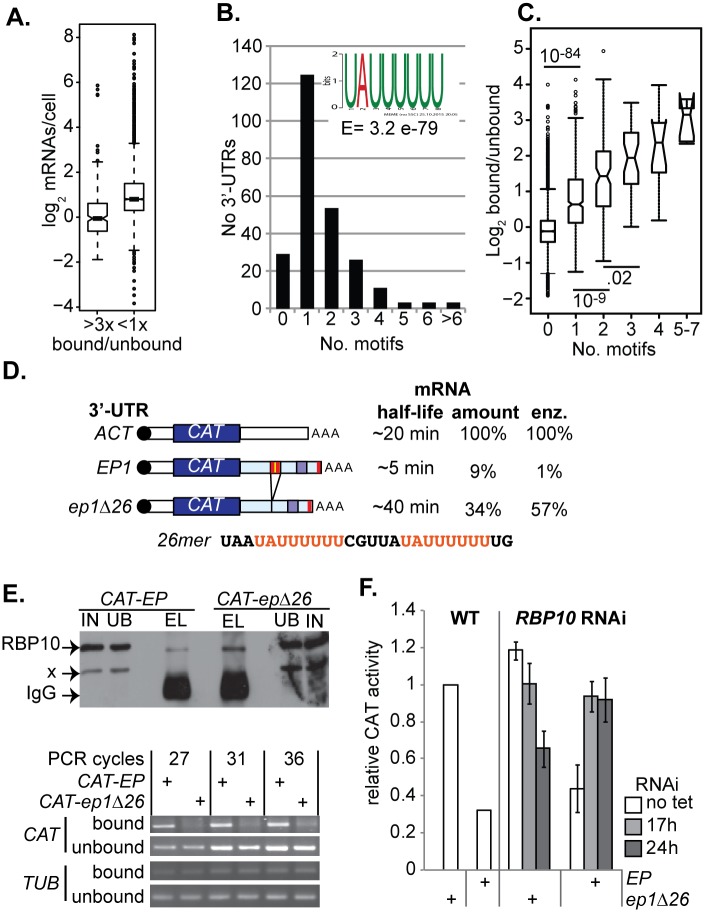
RBP10 targets a UAUUUUUU motif.A) Abundances of mRNAs that were at least 3x enriched in both RBP10-bound fraction, relative to those that were less than 1x enriched. B) The 3'-UTRs of 188 mRNAs that were at least 3x enriched in both RBP10-bound samples (Supplementary S2 Table) were compared with those of mRNAs that did not bind (<0.7x enrichment in both experiments) using DREME. Only 3'-UTRs annotated in tritrypDB were used (S1 and S2 Text) and some were not mapped with sufficient confidence to be included. The best-scoring motif found is shown in the inset. The graph shows numbers of UA(U)6 motifs in 255 manually annotated bound 3'-UTRs (S2 Table). One mRNA each had 7, 8 and 9 motifs. The numbers of motifs shown here are sometimes higher than with automatically annotated 3'-UTRs from the genome database, because some of the automatic 3'-UTRs are truncated. C) Effect of the UA(U)6 motif on RBP10 binding: median ± 25th percentiles, with 95% confidence limits and outliers. Database 3'-UTRs were analyzed. Since these are often truncated, and are missing for 30% of genes, the numbers of motifs are under-estimated. Significant differences (Student t-test) are shown. D) Reporters used in (E) and (F) [42]. The red bars are UAUUUUUU elements, which are highlighted in the 26mer sequence. E) RBP10 binding to the EP 3'-UTR requires the 26mer. Cells were UV-irradiated, and RBP10 was pulled down with anti-RBP10 (upper panel, Western blot). RNAs were detected by reverse transcription and PCR using gene-specific primers (lower panel). If reverse transcriptase was omitted, no PCR band was obtained. F) rbp10 RNAi specifically affects expression of a reporter containing the 26mer. CAT activity was measured 17h and 24h after RNAi induction.